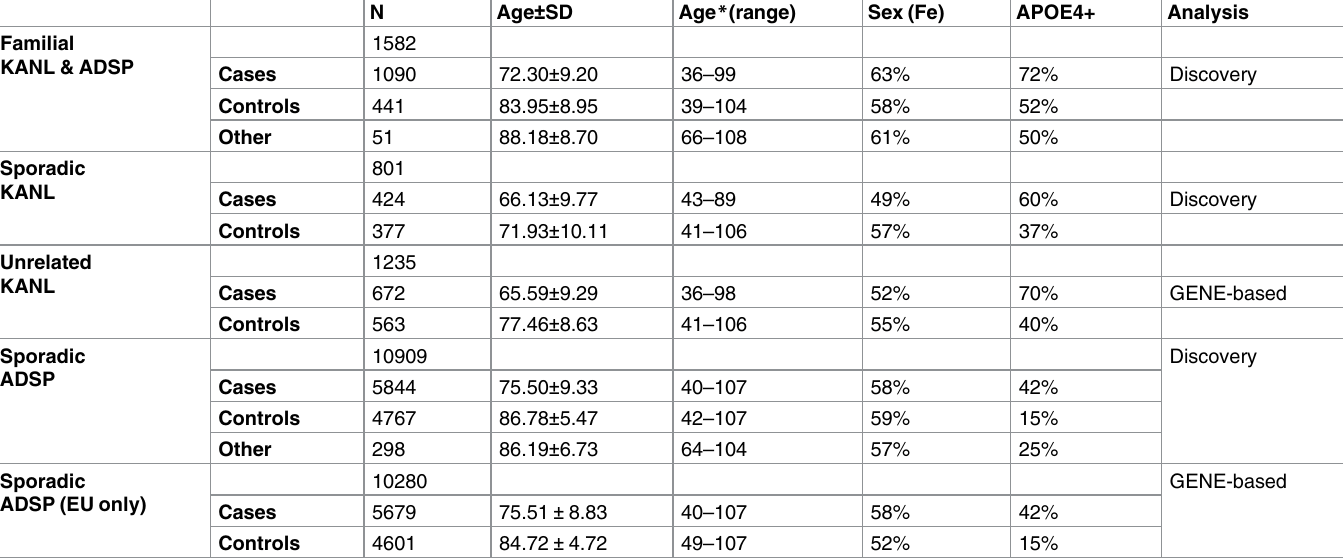
Table 4. Demographic data for the cohorts employed in this study and analysis plan.